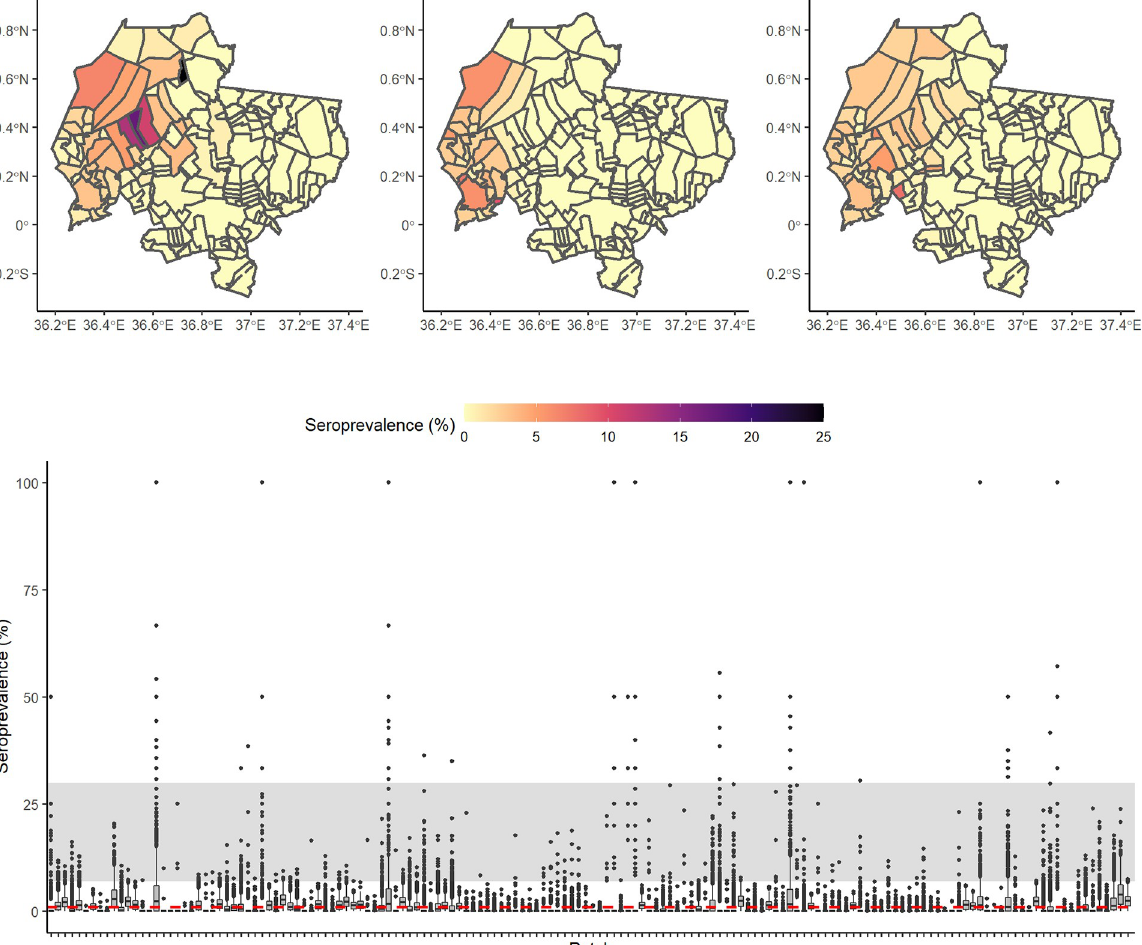
Fig 5. Spatial variation in seroprevalence between patches from model simulations for scenario B, with R 0 = 1.2 and δ = 1/365. a) Maps of Laikipia County showing seroprevalence in each patch at 30 years post introduction from three randomly selected simulations. Patch boundaries were generated from a shapefile of property boundaries from Mpala Research Centre, Laikipia County, Kenya [47]. b) Boxplots showing variation in seroprevalence in all patches at 30 years post introduction. The grey band indicates the range of seroprevalence considered plausible based on empirical estimates, as shown in Table 3. The red dotted line indicates the median population-level seroprevalence.